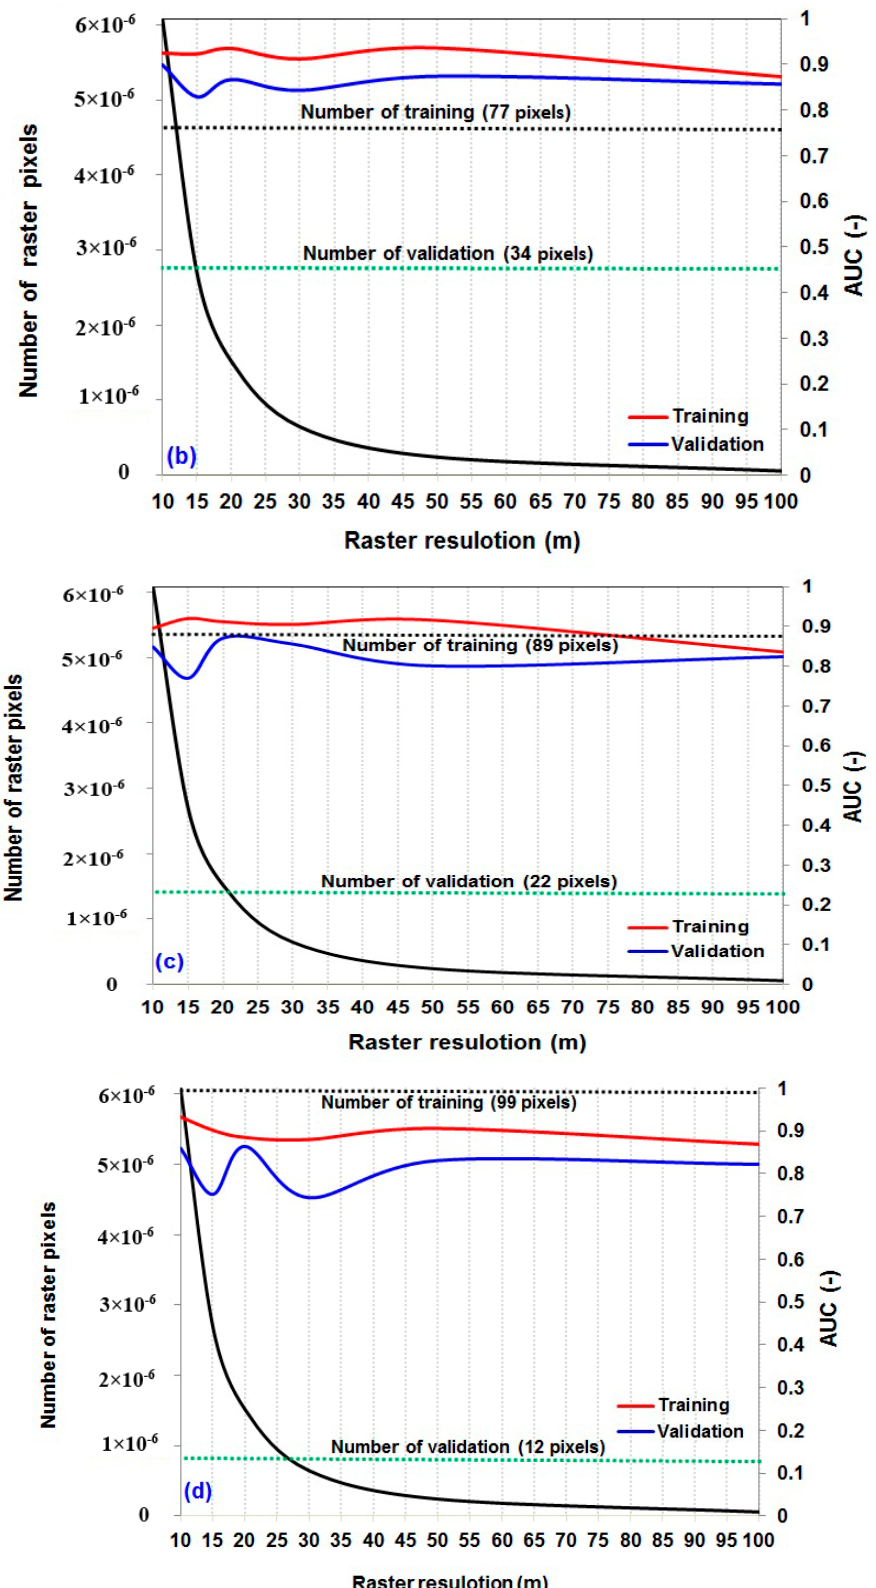
Figure 4. The effects of sample size and raster resolution on the performance of landslide modeling: ( a ) sample size of 60%/40%; ( b ) sample size of 70%/30%; ( c ) sample size of 80%/20%; and ( d ) sample size of 90%/10%.